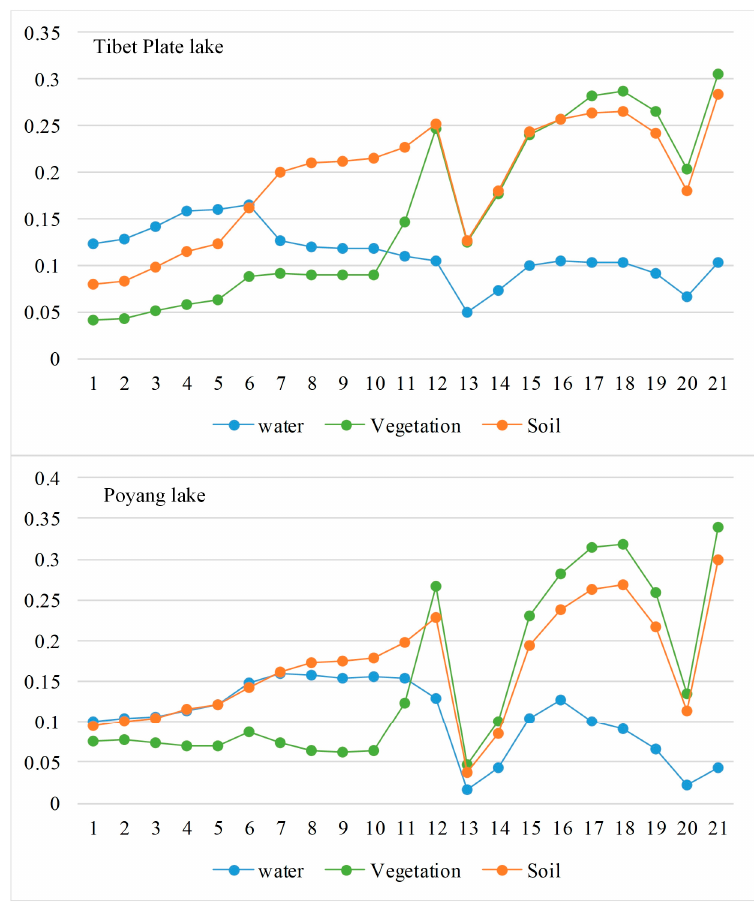
Figure 4. Spectral response curves of water, vegetation, and soil in the Sentinel-3 OLCI image for the Tibet Plate lake and Poyang lake.